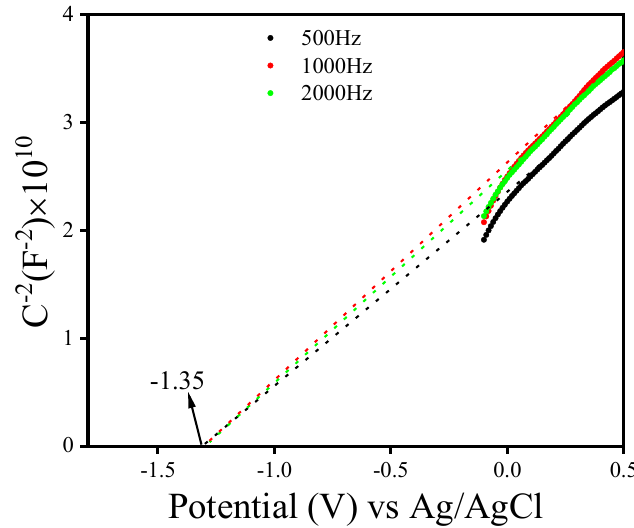
Figure 10. The Mott–Schottky plot of the 0.9P-CNT sample.